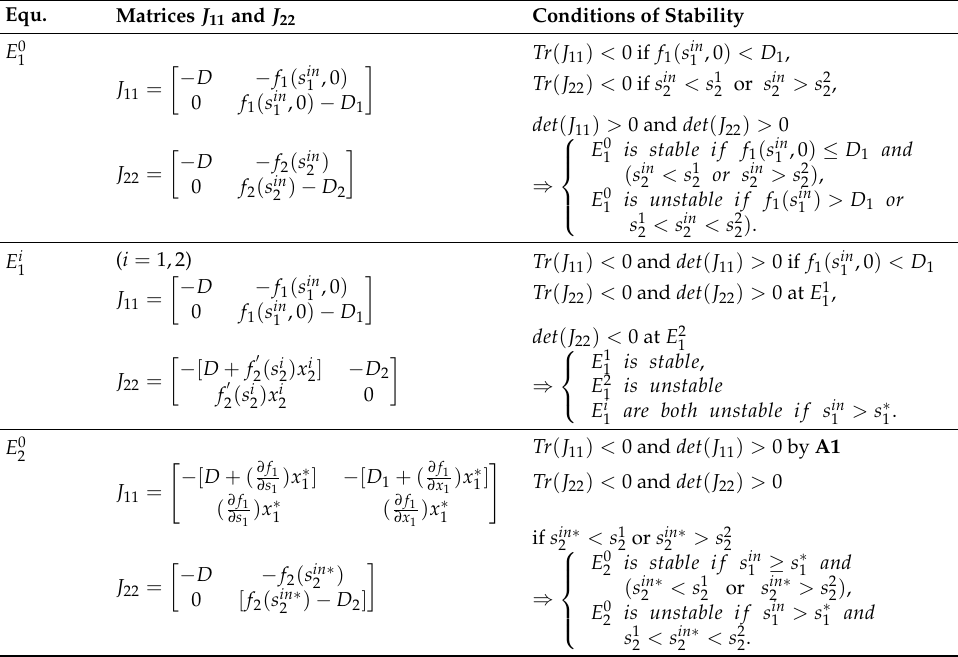
Table 5. The stability conditions for the steady states of System (4). Equ. Matrices J 11 and J 22 Conditions of